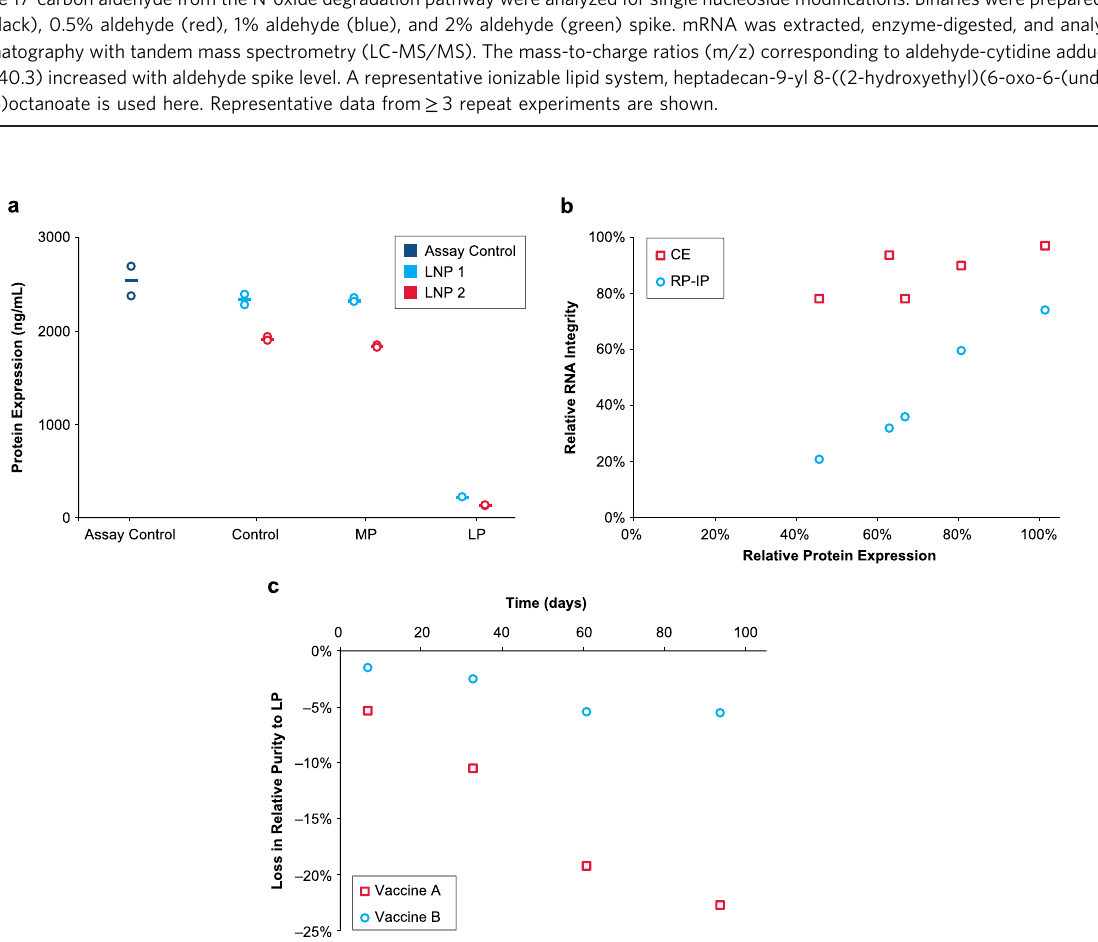
Fig. 6 mRNA adduction reduces protein expression. a Isolated main peak (MP) and late eluting-peak (LP) alongside control mRNA-lipid nanoparticle (mRNA-LNP) and an assay positive control were tested for in vitro protein expression in BJ fi broblasts after 48 h. RNA was extracted from 2 hEPO-LNP formulations by isopropanol precipitation and puri fi ed by RP-IP to generate MP and LP prior to transfection. The assay control is a pure hEPO mRNA standard, the control sample is mRNA extracted from each formulation prior to RP-IP separation, and the MP and LP are isolated fractions. Results from 2 replicate transfection wells is plotted with the mean. b Five different mRNA-LNP samples were prepared using different ionizable lipids and incubated at 5 °C to generate varying levels of adduct and degradation. RNA was extracted from the mRNA-LNP by isopropanol precipitation and evaluated by reversed phase-ion pair (RP-IP), capillary electrophoresis (CE), and in vitro protein expression in HeLa cells as measured by mean fl uorescence intensity. Relative expression as a percentage of the neat mRNA expression is plotted versus relative integrity as a percentage of the neat mRNA integrity, determined by relative area using both CE and RP-IP HPLC. c Loss in mRNA purity to adduct formation in 2 vaccine formulations is plotted over 3 months at refrigerated conditions. Poor process control led to high LP in Vaccine A, but adduct was well-controlled in Vaccine B. Representative data are shown for 3 repeat experiments for Fig. 6a and multiple repeat experiments for Fig. 6b and